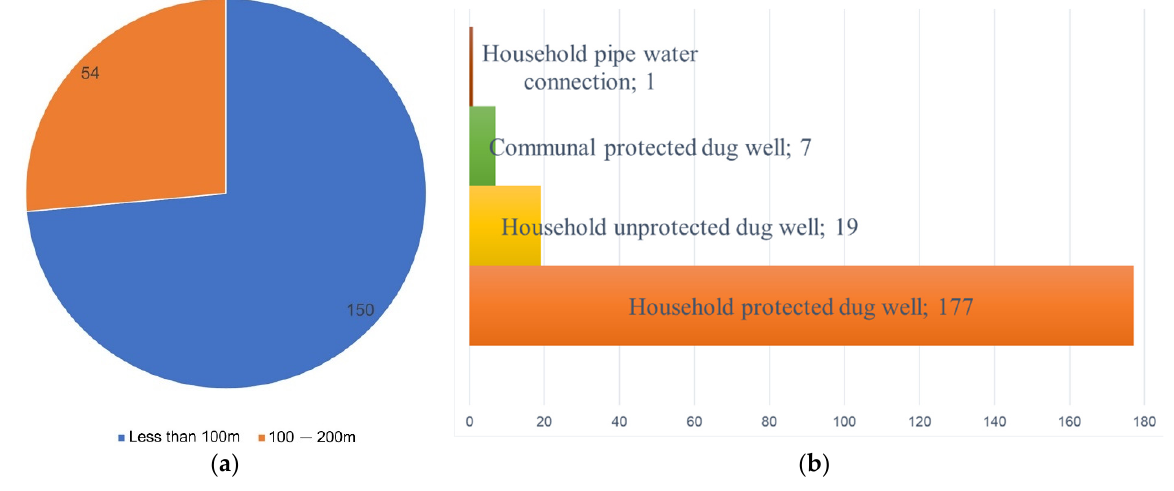
Figure 2. Water as a natural capital to adapt to flooding. Distance from household to water source ( a ); infrastructure and ownership of water source ( b ). Obtained from: Fieldwork. Individuals who cannot access safer drinking water are exposed to cholera, diarrhoea, typhoid and other waterborne disease conditions connected with polluted flood